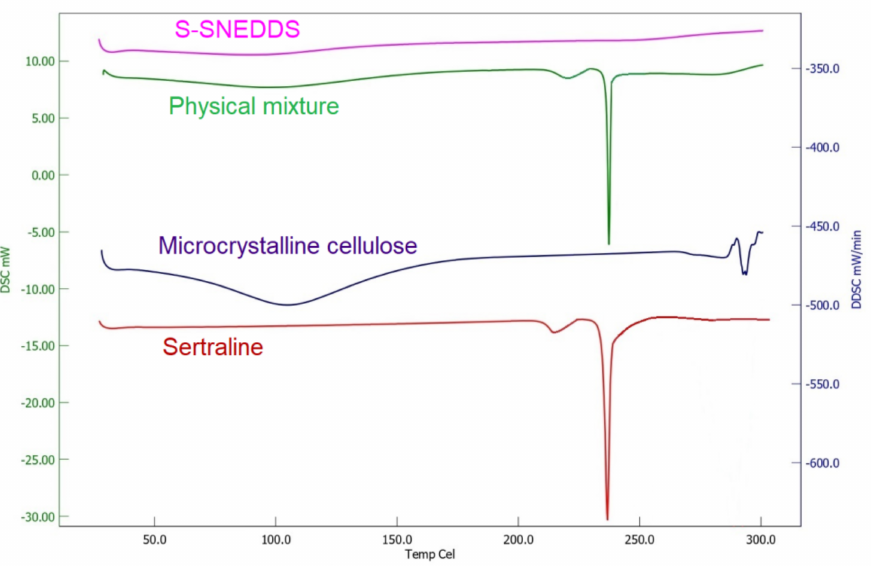
Figure 10. Differential scanning calorimetric thermograms of sertraline, microcrystalline cellulose, physical mixture, and prepared solid self-nanoemulsifying drug delivery system